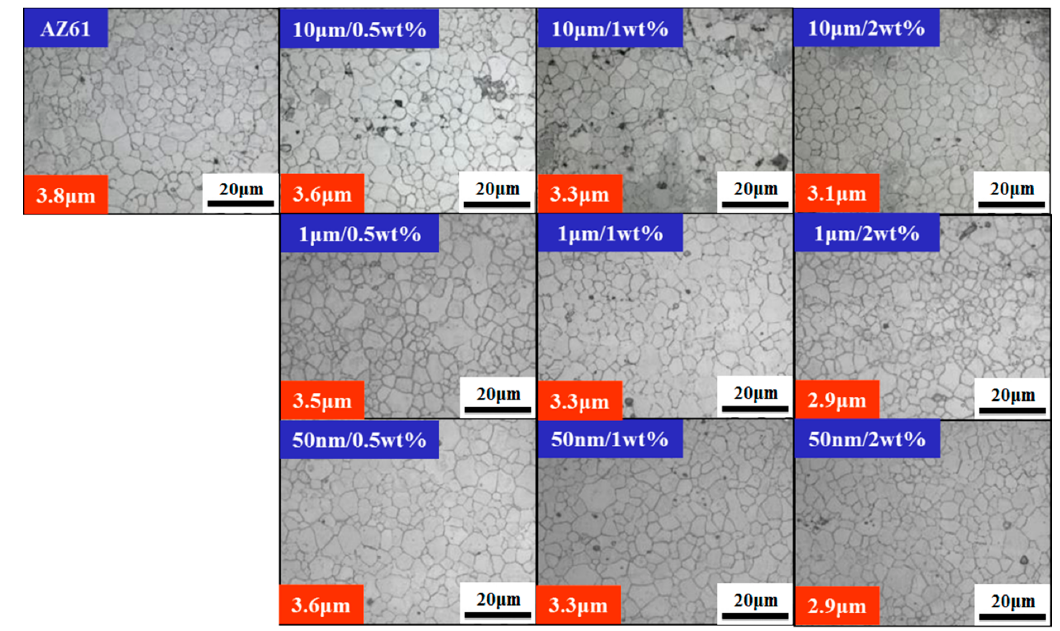
Figure 10. Metallography of the AZ61/SiCp MMCs extruded plates before annealing.